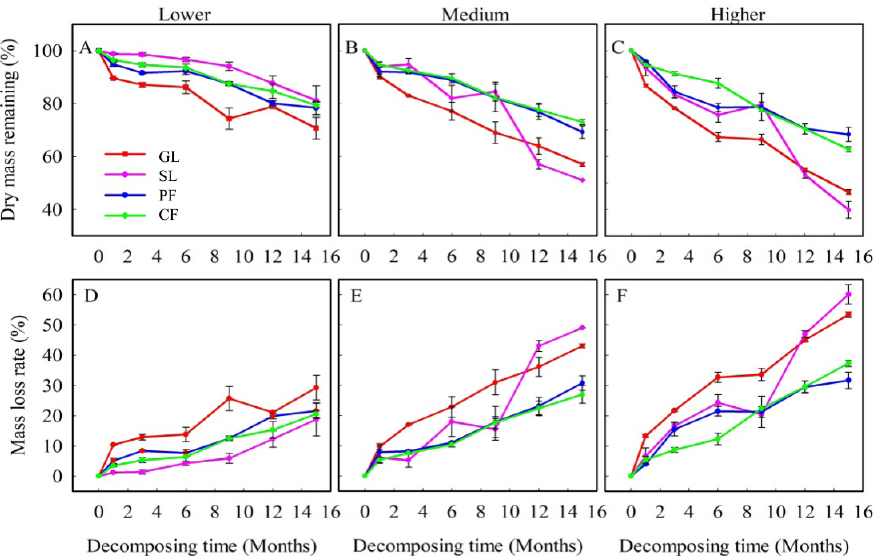
Figure 1. Dynamics of litter biomass loss and decomposition rate changed with decomposing time (months) in different restoration stages. Lower, medium, higher represent three different water gradients, respectively. GL, grassland; SL, shrubland; PF, pioneer forests; CF, climax forests. ( A – C ) represent the dry mass remaining under lower water, medium water and higher water treatment, respectively; ( D – F ) represent the mass loss rate under lower water, medium water and higher water treatment, respectively. All bars represent the mean ± standard error. Table 1. Stepwise regression analysis of litter decomposition rate with litter propertie s.